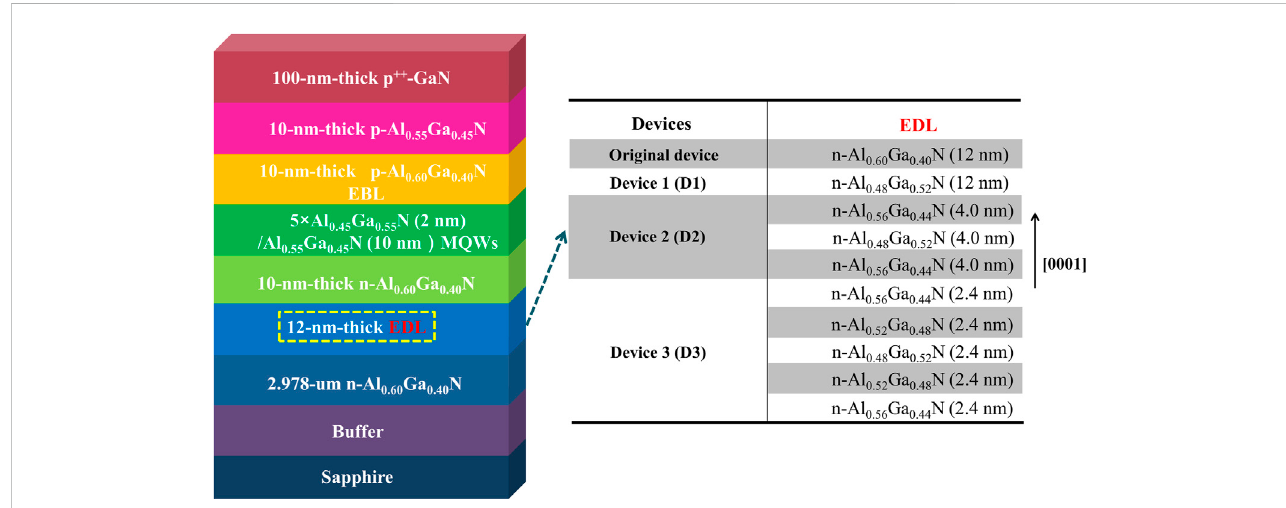
FIGURE 1 (Color online) Schematic diagrams of AlGaN-based DUV LEDs with Original, D1, D2, and